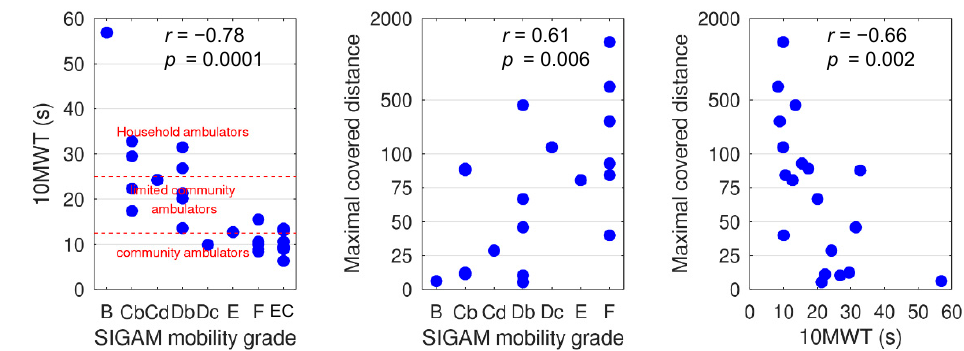
Figure 3. Relation between the SIGAM mobility grades, the 10 MWT, and the maximal covered distance. B = Therapeutic use only for transfers, C = Walks on level ground less than or equal to 50 m with (Cb) / without aids (Cd), D = Walks outdoor on level ground only, in good weather, more than 50 m with 2 crutches / sticks (Db) or 1 crutch / stick (Dc), and E = Walks more than 50 m, no aids, except in adverse terrain or weather, F = normal or near normal gait. EC = elderly